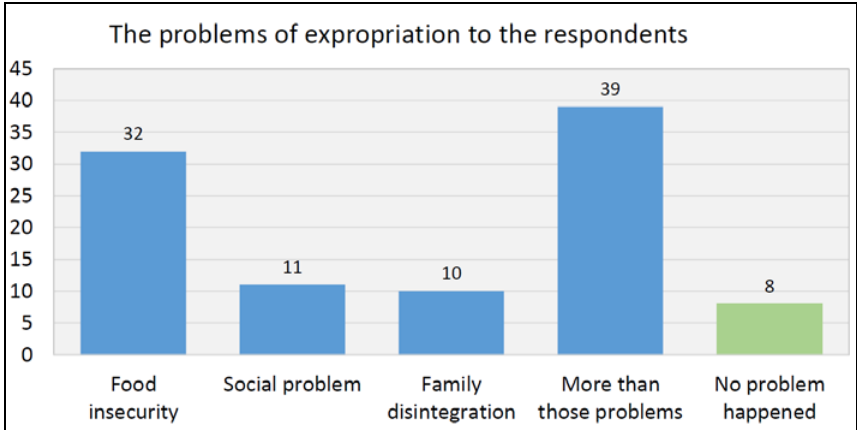
Figure 3. Distribution of sample households by types of problems due to expropriation. Source: Household survey, n = 100,